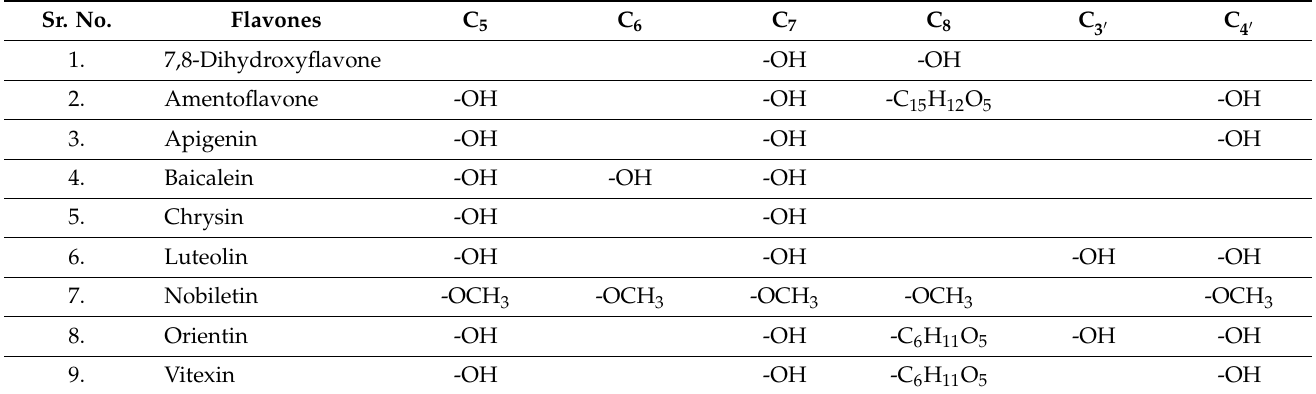
Table 1. Flavones and their Structure activity relationship.